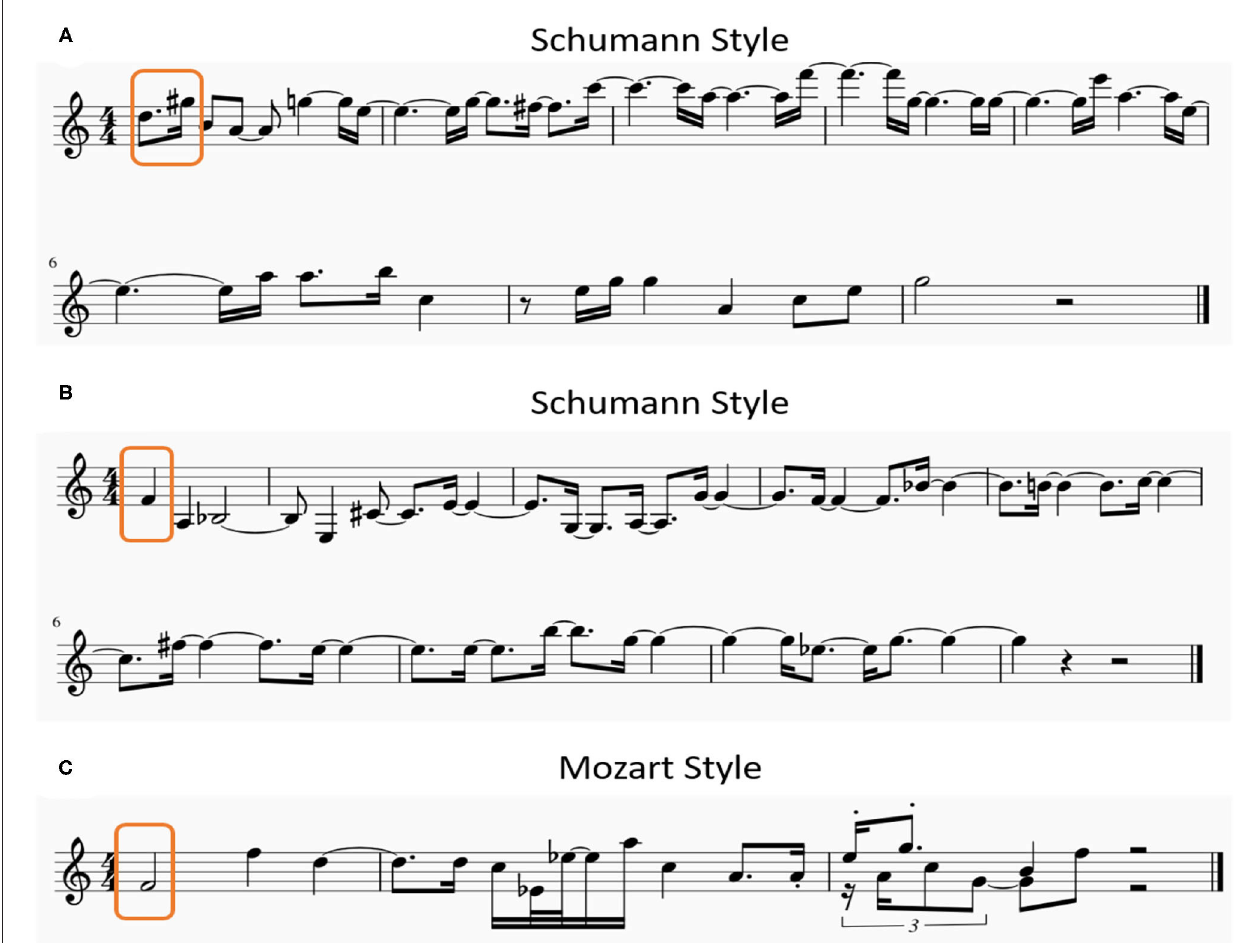
FIGURE 11 | Three examples of melodies generated by the model, (A,B) have the same composer’s style but begin with different seed notes, (B,C) are generated by the same seed notes but with the different composers’ characteristics.